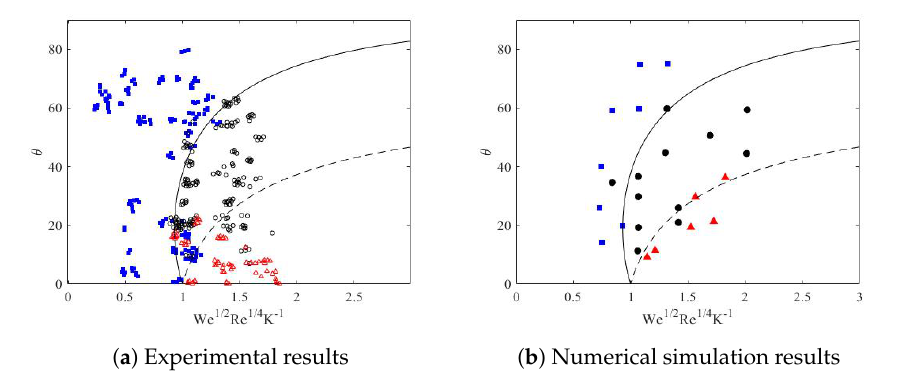
( b ) Numerical simulation results Figure 4. Displays the different cases with We 1/2 Re 1/4 / K and impact angle θ , the three cases are: deposition (marked in blue), single-sided splashing(marked in black) and omni-directional splashing (marked in